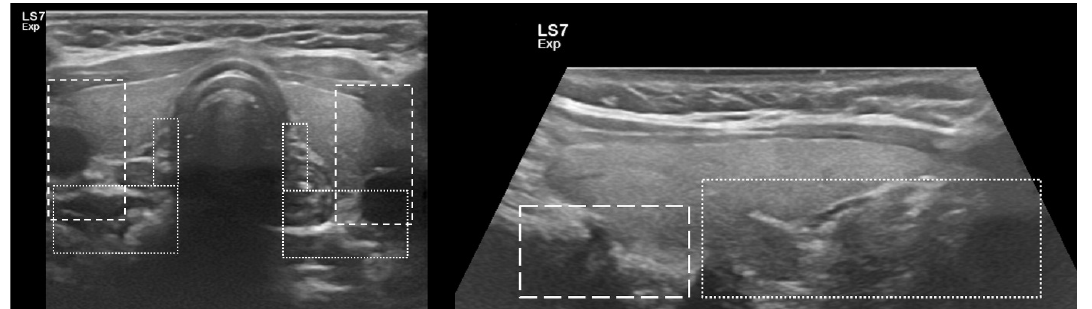
Figure 2. Area of the most common localization of parathyroid glands; superimposed on USG images. Left part—horizontal section; right part—longitudinal section. Superior parathyroid glands—lines; inferior parathyroid glands—dots.